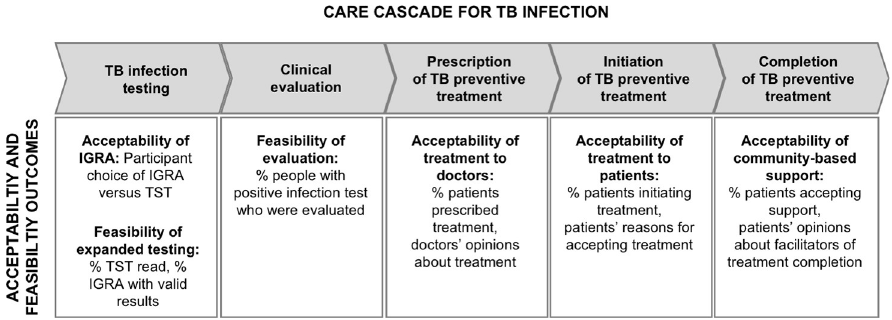
Fig 2. TB infection care cascade framework and key acceptability and feasibility outcomes of study. Abbreviations: TB = tuberculosis, IGRA = interferon gamma release assay, TST = tuberculin skin test.